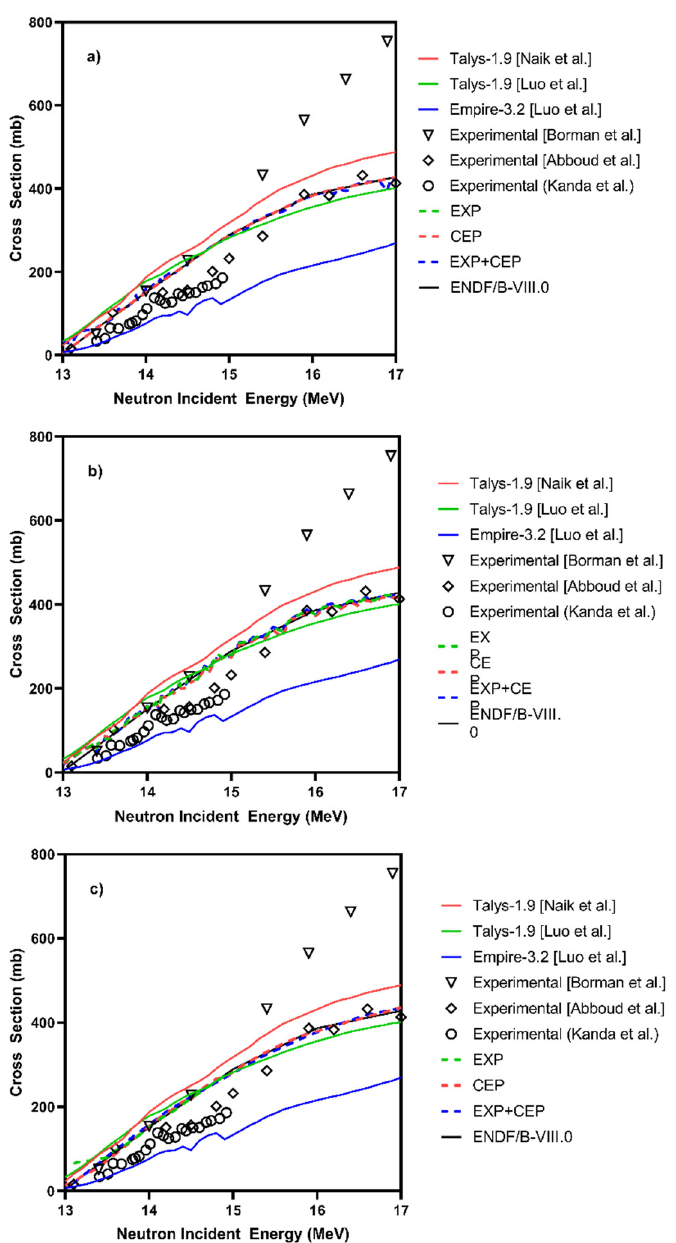
Figure 5. Comparisons between the EXP, EXP + CEP, and CEP using ( a ) GPR, ( b ) RF and ( c ) SVM algorithms.